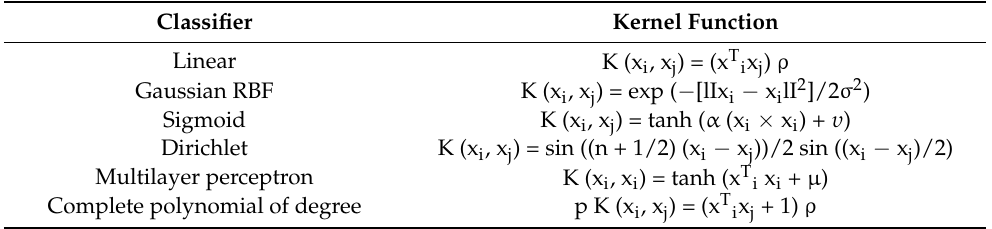
Table 2. SVM kernel